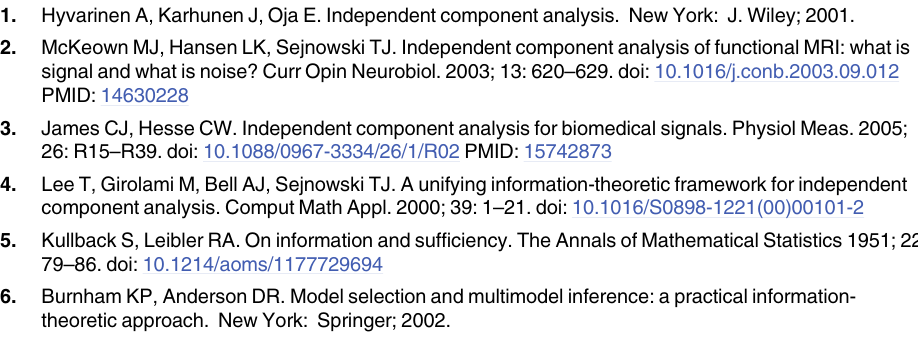
S67 Fig. Gaussian component from the full craniometric data set. See Fig. 6 for formatting details. S68 Fig. Gaussian component from the full craniometric data set. See Fig. 6 for formatting details. S69 Fig. Gaussian component from the full craniometric data set. See Fig. 6 for formatting details. S70 Fig. Gaussian component from the full craniometric data set. See Fig. 6 for formatting details. S71 Fig. Gaussian component from the full craniometric data set. See Fig. 6 for formatting details. S72 Fig. Heat map relating z-scores to sources and components for the full craniometric data set. See Fig. 11 for formatting details. The first column corresponds to the Sub-Gaussian source shown in S1 Fig. Columns 2 – 41 correspond to the Super-Gaussian sources in the same order as shown in S2 – S41 Figs. Columns 42 – 71 correspond to the Gaussian components in the same order as shown in S42 – S71 Figs. S1 Table. Coefficients to compute reduced dimension non-Gaussian source scores and Gaussian component scores from the raw measures. S2 Table. Coefficients to compute full dimension non-Gaussian source scores and Gaussian component scores from the raw